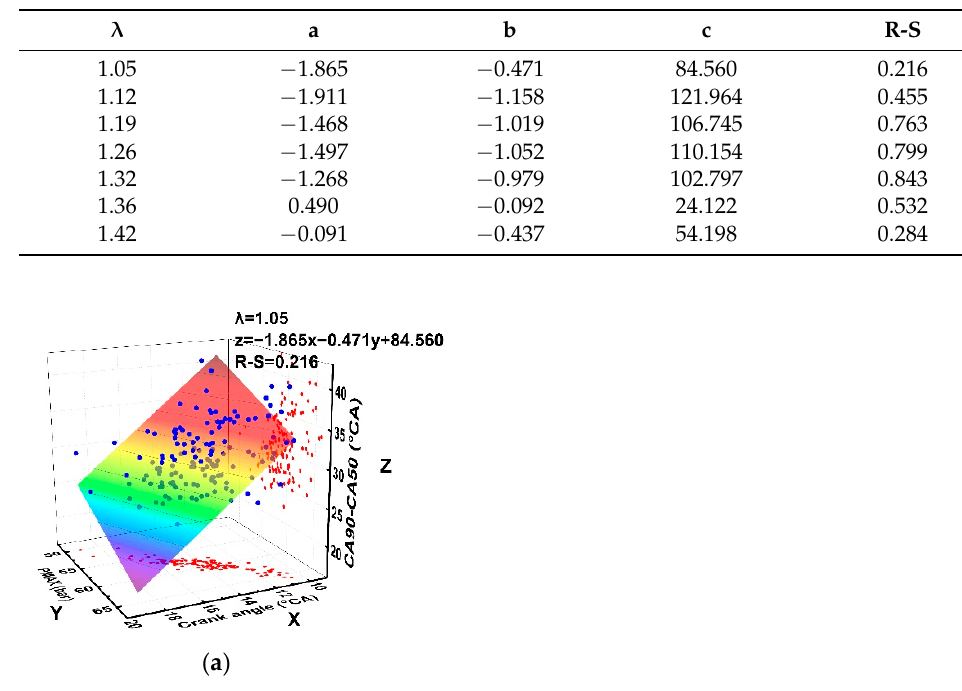
Figure 10. Fitting of CA50-CA05 and PMAX distribution under different λ : ( a ) The fitting of CA50- CA05 and PMAX at λ = 1.05; ( b ) The fitting of CA50-CA05 and PMAX at λ = 1.26; ( c ) The fitting of CA50-CA05 and PMAX at λ = 1.42. Table 9. Fitting parameters of CA50-CA05 and PMAX distribution under different λ .